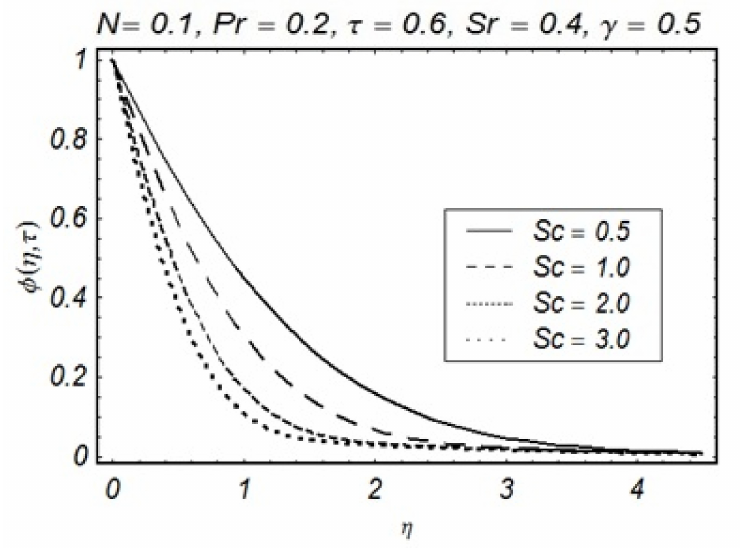
Figure 14. Indication of Sc on solute